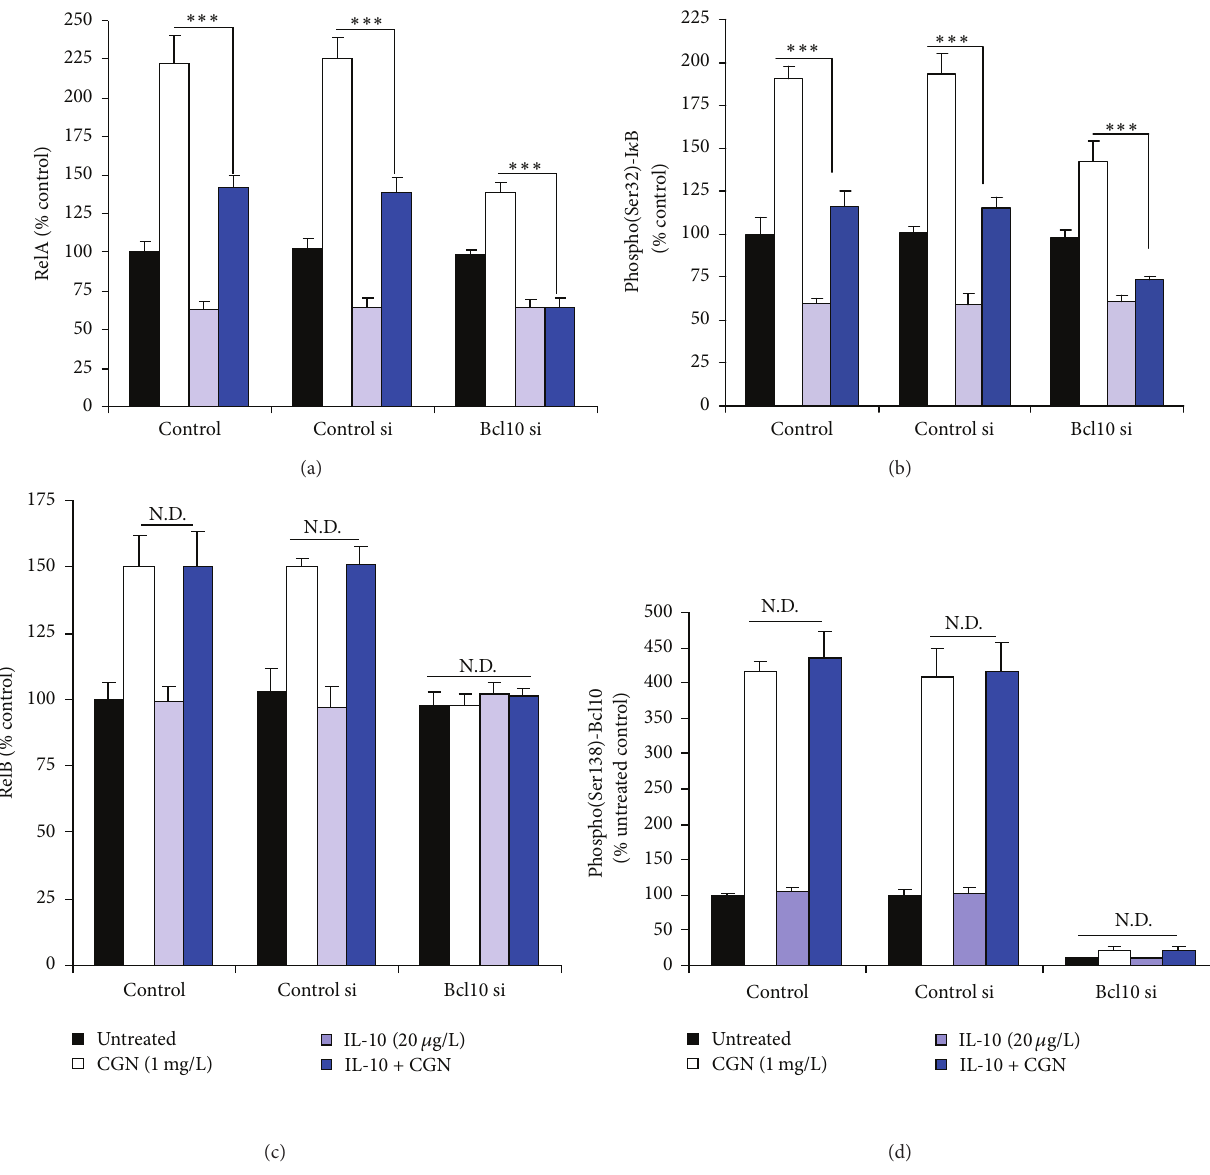
Figure 8: In NCM460 cells, exogenous IL-10 inhibits the canonical but not the non-canonical NF- 𝜅 B pathway that is activated by carrageenan and mediated by Bcl10. (a) Increase in RelA following exposure to carrageenan was partially inhibited by exogenous IL-10 in the NCM460 cells. When Bcl10 was silenced by siRNA, the increase in RelA was reduced and completely inhibited by IL-10 (20 𝜇 g/L × 24 h). (b) The increase in phospho(Ser32)-I 𝜅 B 𝛼 was partially inhibited by exogenous IL-10 in the control and control siRNA cells. The increase was less when Bcl10 was silenced and was almost completely inhibited by exogenous IL-10. (c) In contrast to the above findings, the increase in RelB was unaffected by exogenous IL-10. (d) Phospho(Ser138)-Bcl10 increased to over four times the baseline in the control and control siRNA cells, and the increases were not inhibited by exogenous IL-10. ND: no difference; IL-10: interleukin-10; si: small interfering siRNA; CGN: